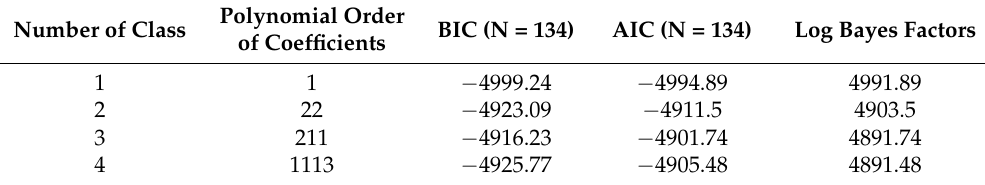
Table 2. Results of model